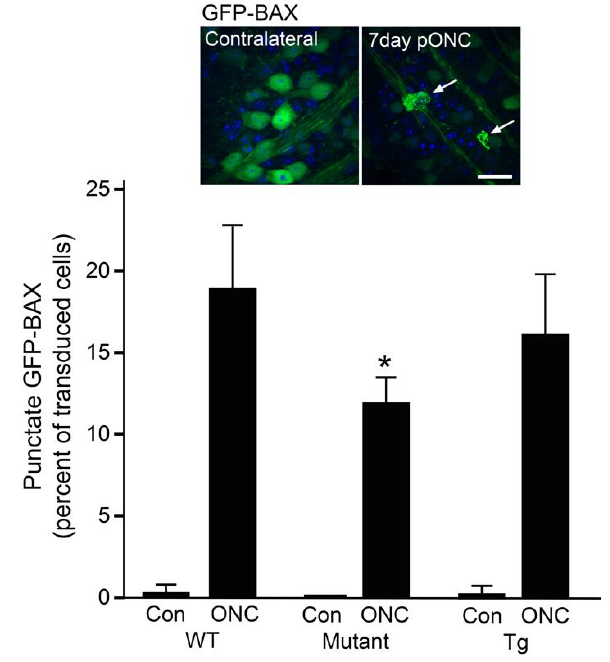
Figure 8. RGCs with larger mitochondria exhibit a reduced level of BAX recruitment to mitochondria after optic nerve damage. RGCs undergo intrinsic apoptosis in response to optic nerve damage, which is dependent on the pro-apoptotic function of the protein BAX. During this process, BAX translocates from the cytosol to the mitochondrial outer membrane and forms bright puncta that are associated with the formation of large molecular weight BAX oligomers [68]. The recruitment of BAX to the mitochondria during apoptosis in RGCs can be monitored by preloading them with a GFP-BAX fusion protein using AAV2/2 viral mediated gene transfer. To test if the modulation of mitochondrial dynamics exhibited by Tmem135 mutant and Tmem135 overexpressing transgenic mice (Tg) affected BAX recruitment, we preloaded the retinas of these mice with the GFP-BAX fusion protein and then subjected them to optic nerve crush surgery (see Supplemental Methods). At seven days post-crush surgery, the retinas from both crush and contralateral eyes were scored for punctate BAX localization as a percentage of transduced cells. The inset shows transduced RGCs from the contralateral retina and crush retina of a wild type (WT) mouse, with arrows highlighting cells with punctate GFP-BAX. Scale bar = 25 µ m. The bar graph shows that Tmem135 mutant mice still exhibit cells with punctate GFP-BAX in crush retinas, but the level is lower than in the other genotypes (* p =